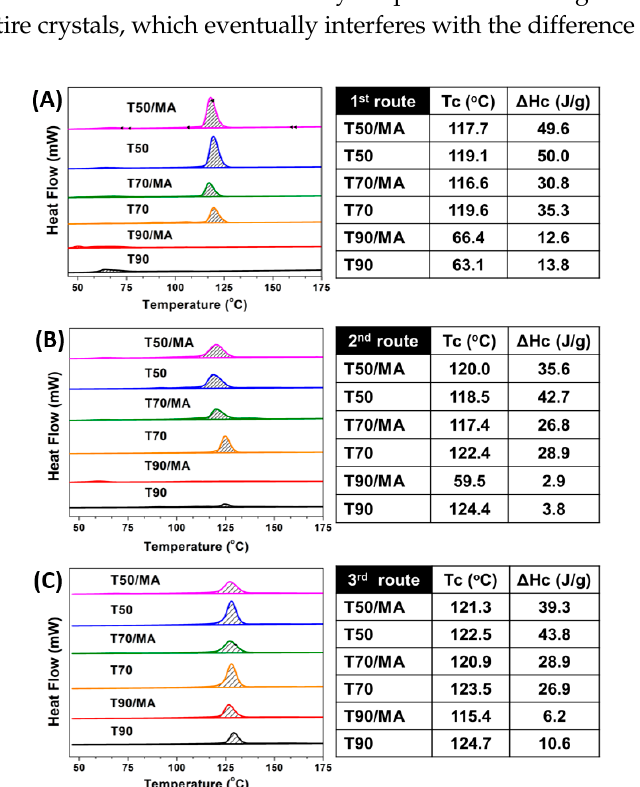
Figure 6. Melting behaviors in the differential scanning calorimetry (DSC) performance of T/P and T/P/MA blends as related to melt-recycling: ( A ) one-off hot-pressing, ( B ) the post-2nd-recycling, and ( C ) the post-3rd-recycling. ** Tm = melting temperature and Δ Hm = melting enthalpy.